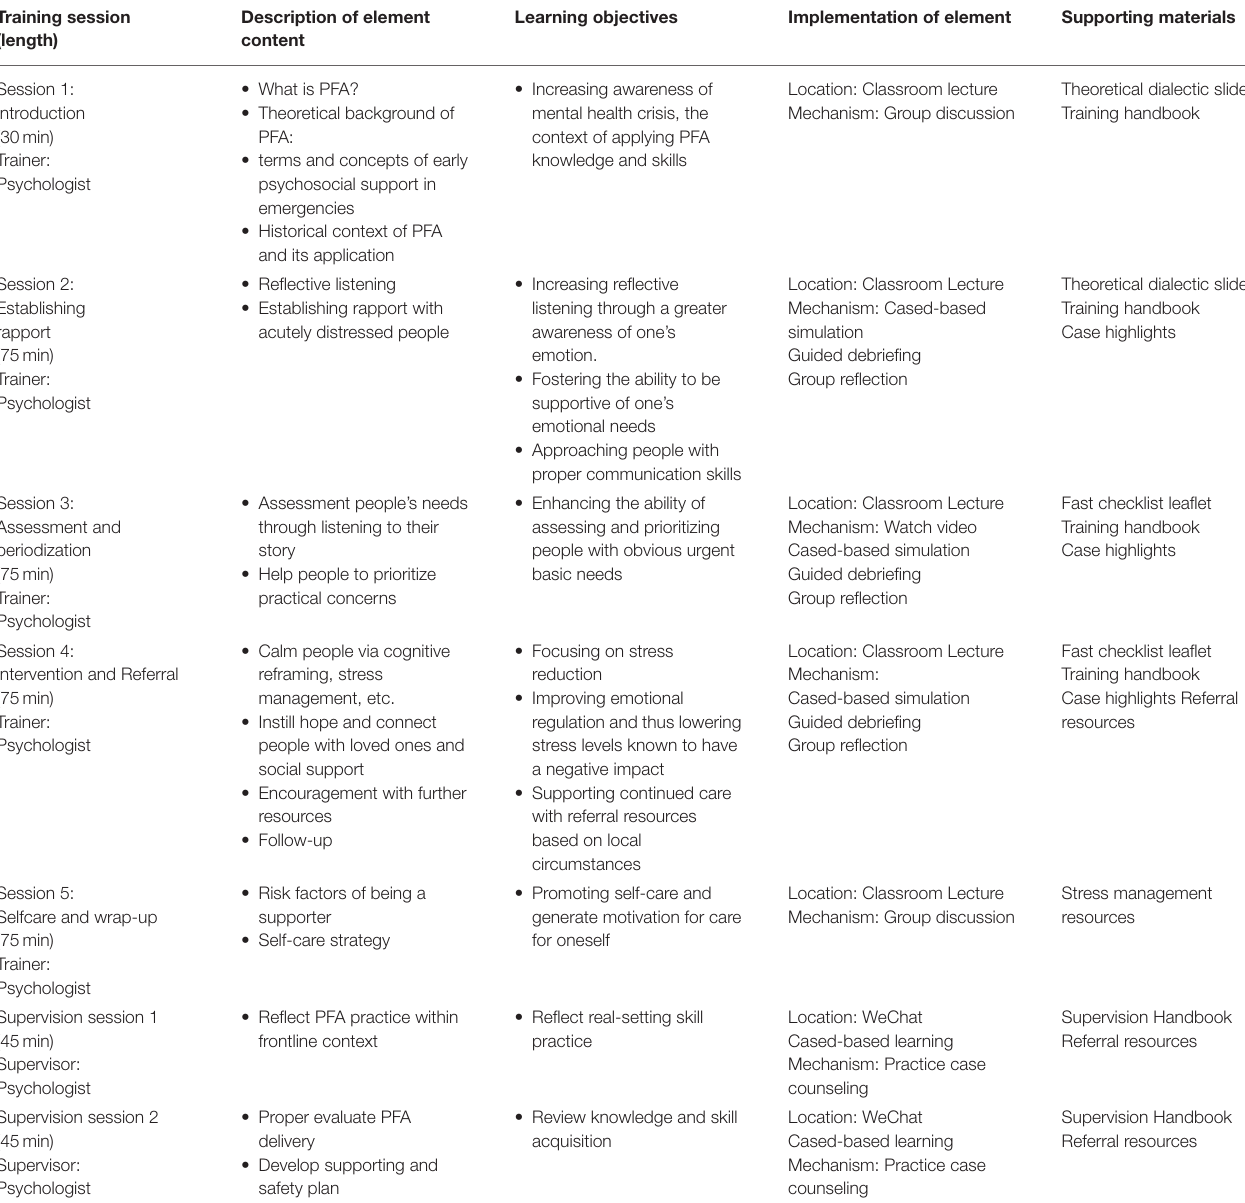
TABLE 1 | “Preparing Me” for Chinese frontline healthcare PFA training intervention. Training session